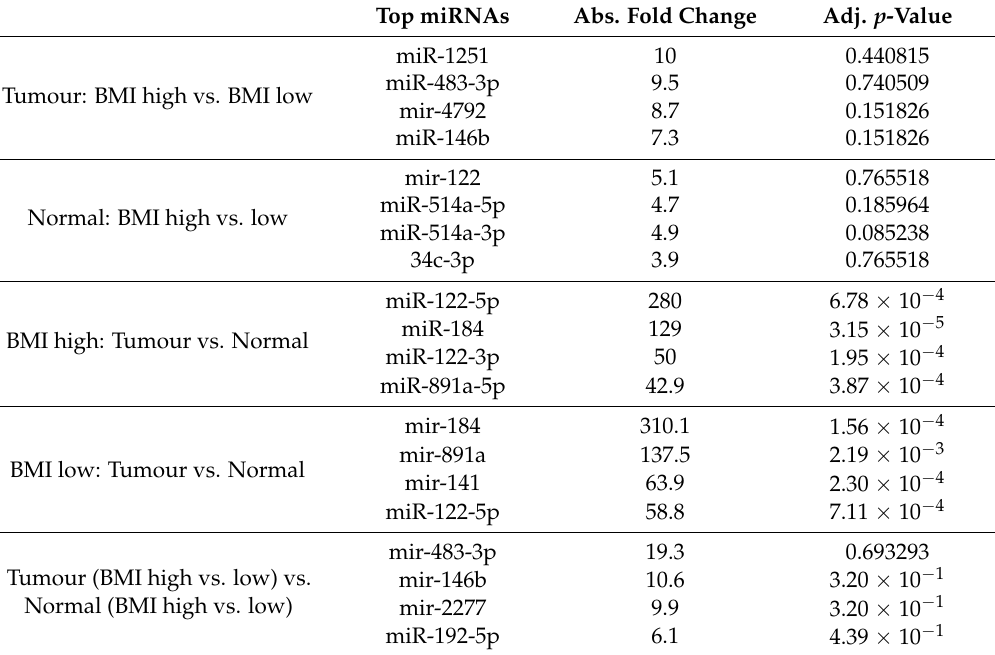
Table A1. Top miRNAs from obesity-related